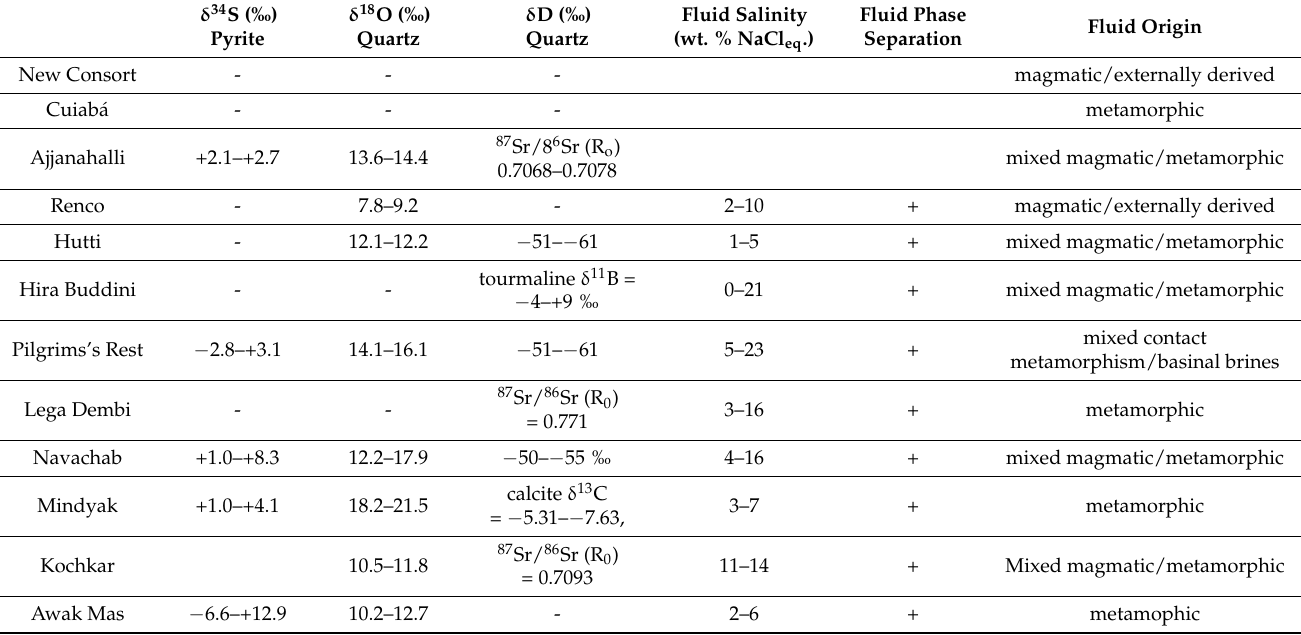
Table 7. Isotopic signatures, physical conditions, and proposed origin of ore